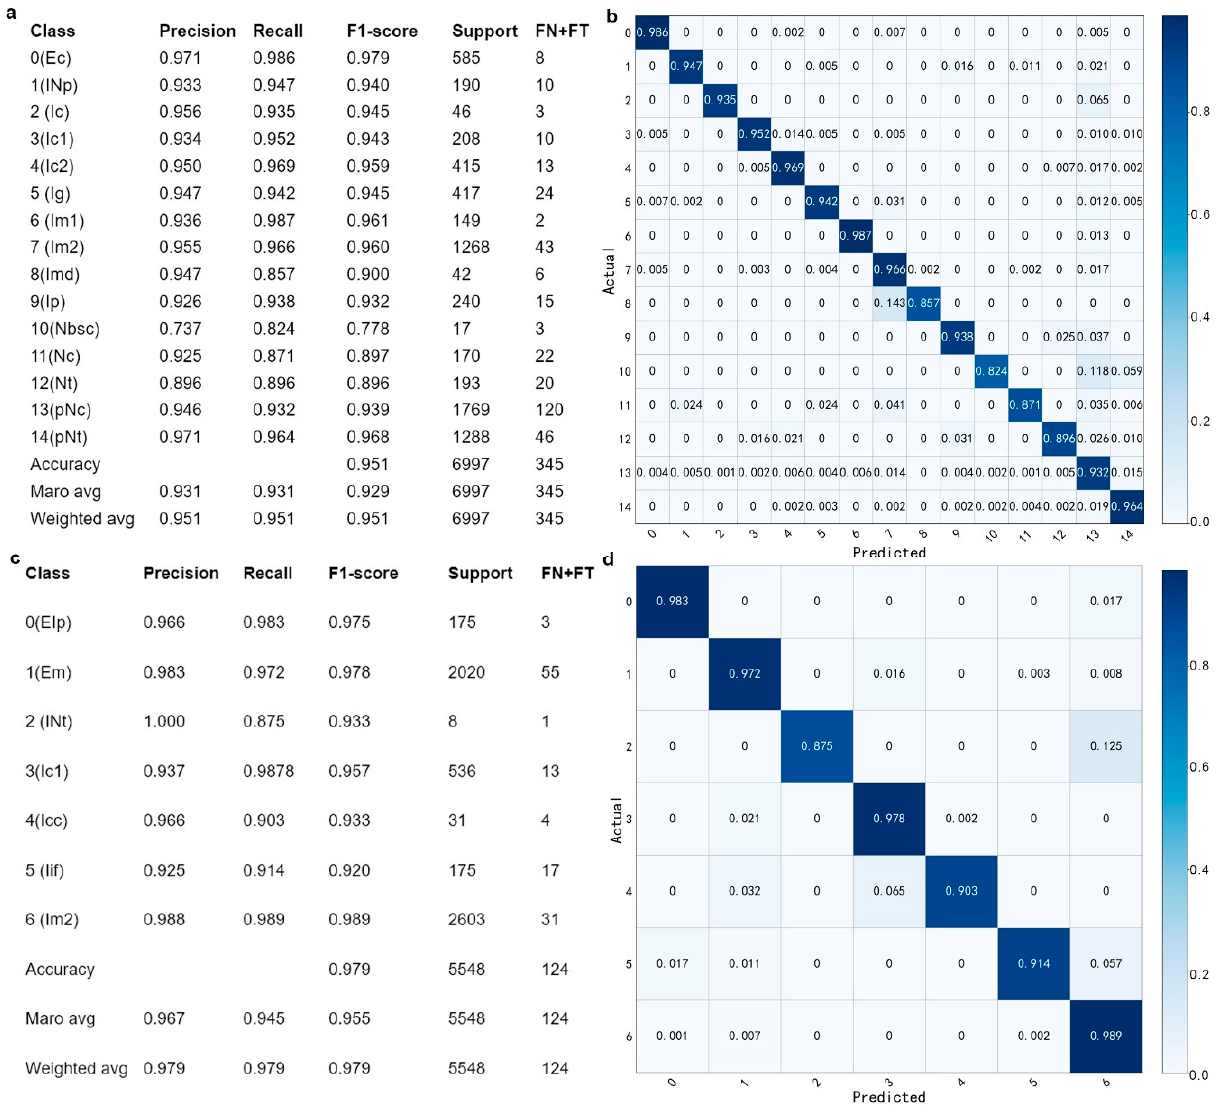
Figure 6. Classification evaluation report and the Recall–Confusion Matrix of the highest classification accuracy for the two study areas. ( a , b ) Classification results of Chang’e-4 landing area obtained on XGBoost + DataSet_4. ( c , d ) Classification results of Chang’e-5 landing area obtained on XGBoost + DataSet_9.